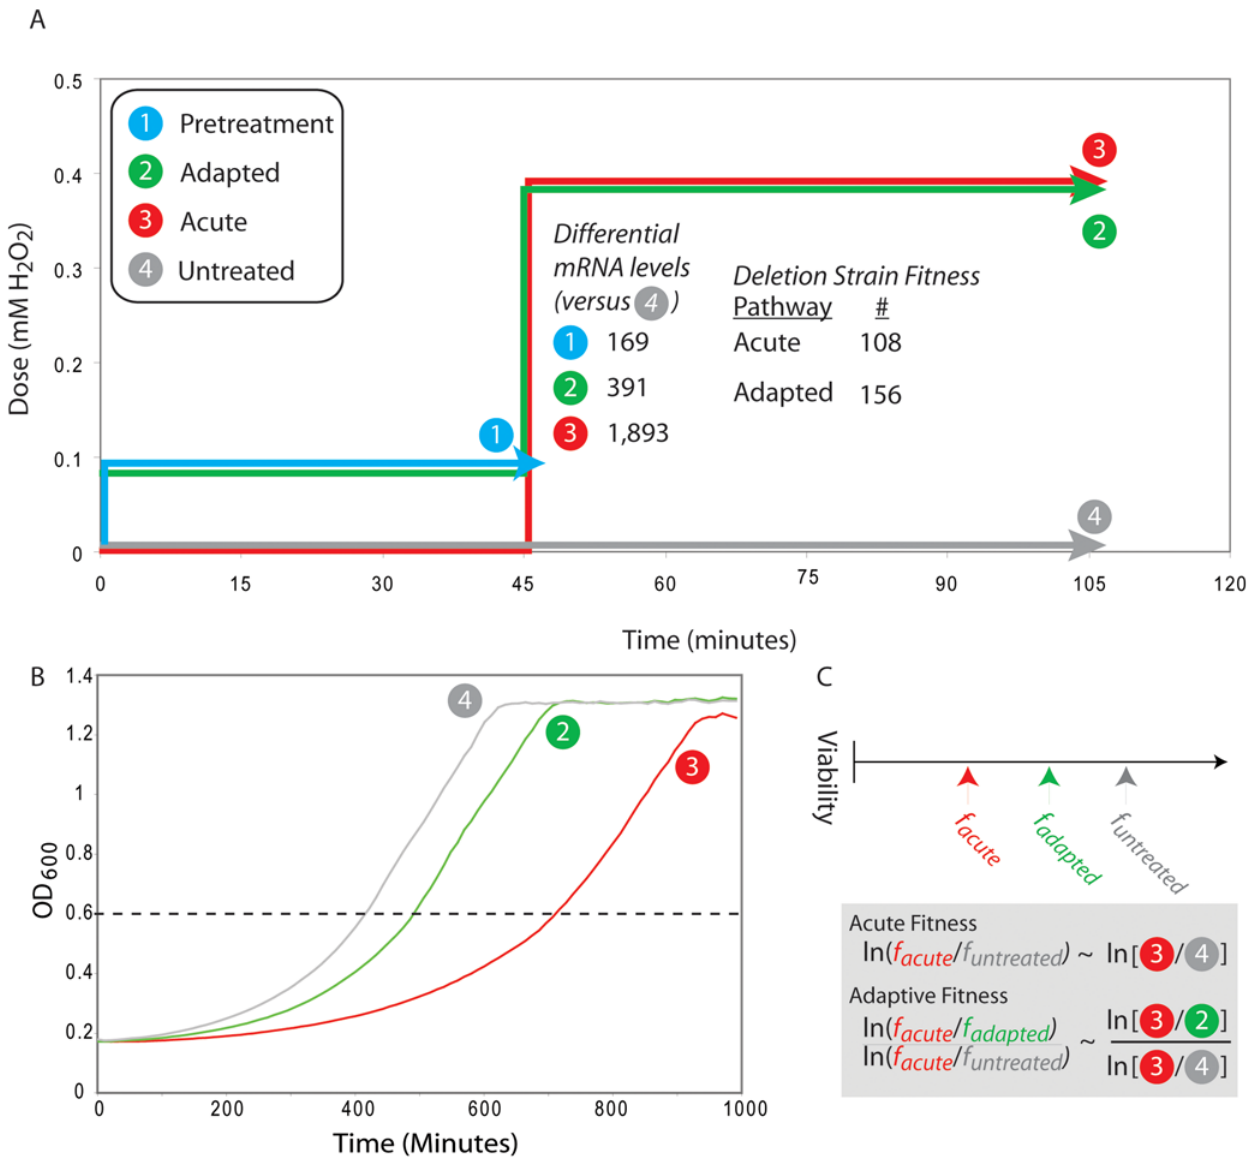
Figure 1. Study design. A. Yeast cells were collected following each of four hydrogen peroxide treatment conditions (pretreated, adapted, acute, and untreated, labeled 1–4). Competitive growth experiments were performed between gene deletion pools grown in adapted versus acute conditions (to identify genes required specifically for adaptation) and between pools grown in acute versus untreated conditions (to identify genes required for the acute response). Gene expression profiling was performed in either adapted or acute conditions versus untreated cells. B. Profiling of wild type growth reveals that pretreatment with mild hydrogen peroxide (green) leads to improved recovery to an OD 600 threshold (dashed line) compared to no pretreatment (red) following a high dose of hydrogen peroxide. An enlarged version of panel B is available as Figure S1. C. For an individual gene deletion, the acute sensitivity is defined as the difference between the acute and untreated viability. The adapted sensitivity is the fraction of that difference that is recovered by mild pretreatment with hydrogen